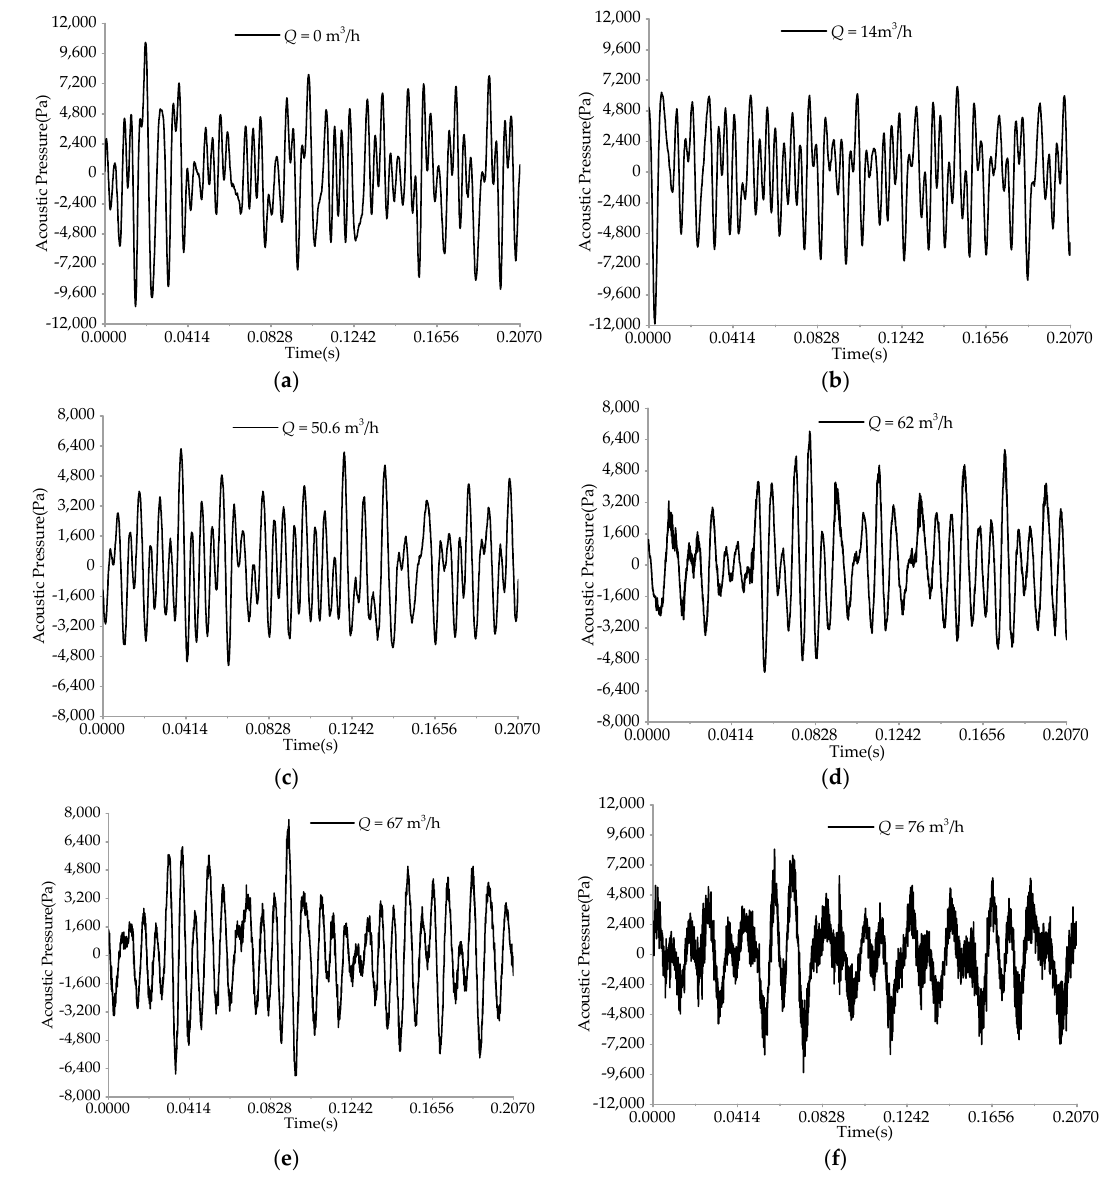
Figure 11. Time domain of the acoustic pressure measured by pump outlet hydrophone 1 at various flow rates. ( a ) Q = 0m 3 /h; ( b ) Q = 14m 3 /h; ( c ) Q = 50.6m 3 /h; ( d ) Q = 62m 3 /h; ( e ) Q = 67m 3 /h; ( f ) Q = 76m 3 /h.